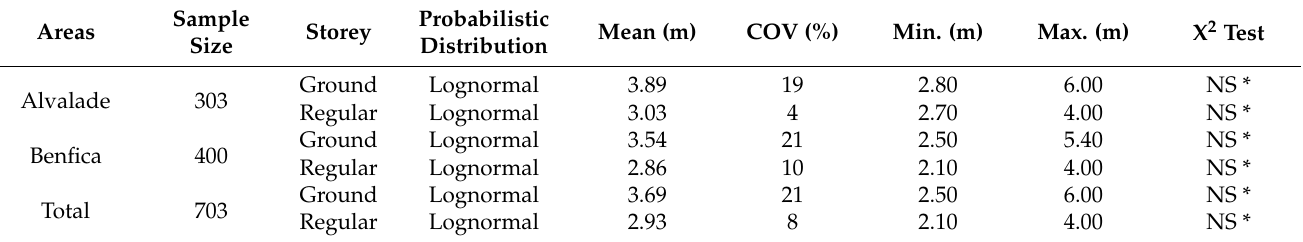
Table 5. Probabilistic distribution of ground and regular storey height for the RC building stock of each